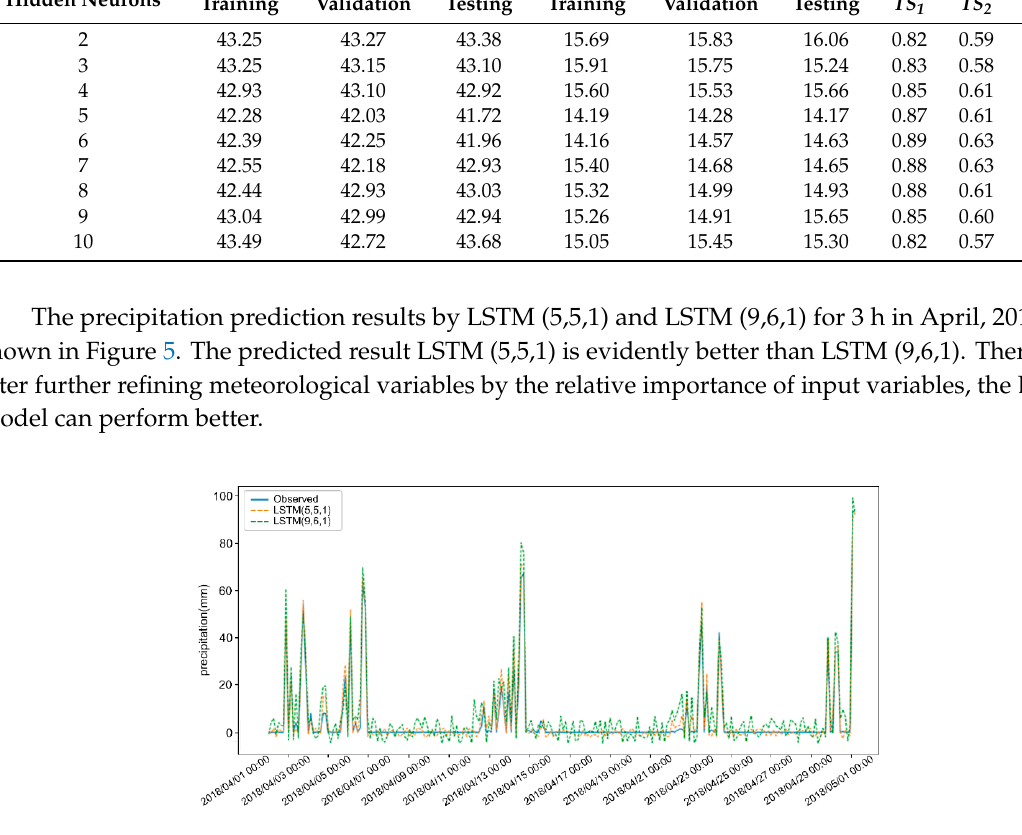
Table 7. The performance for training, validation, and testing parts of the LSTM model with five input variables (height of the lowest clouds (HLC), pressure tendency (PT), temperature (T), atmospheric pressure (AP), and relative humidity (RH)).